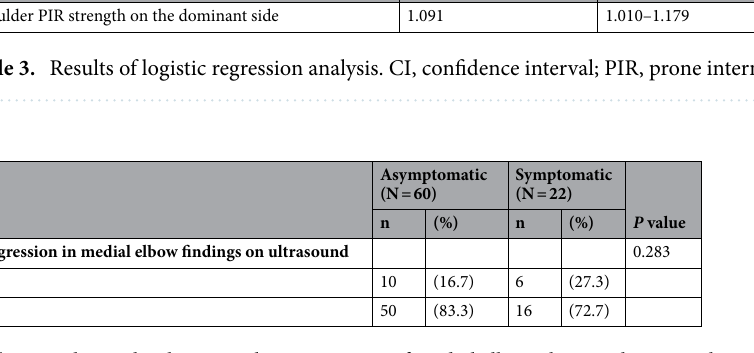
Table 4. Relationship between the progression of medial elbow abnormalities on ultrasound and elbow symptom